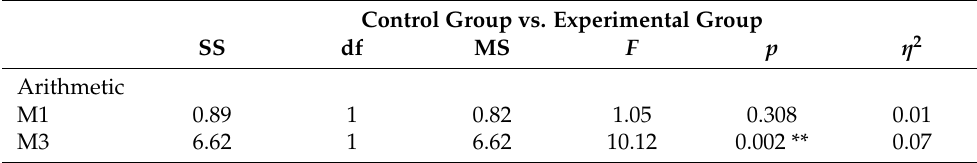
Table 5. Analysis of Variance (ANOVA) unifactorial for arithmetic